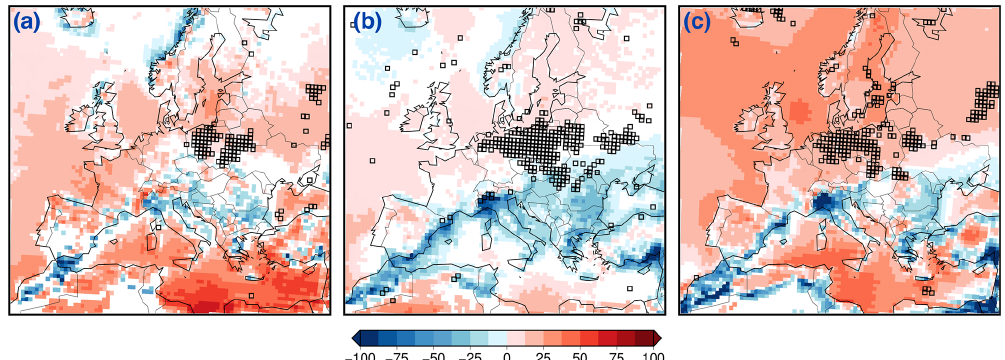
Figure 4. Significant relative differences (colors) between ARCI and ERA5 for (a) precipitation, (b) number of days of precipita- tion > 0.1mm and (c) clouds at low levels. Squares indicate statistically significant differences ( p < 0 . 05). The analysis was conducted for the mean values of the period